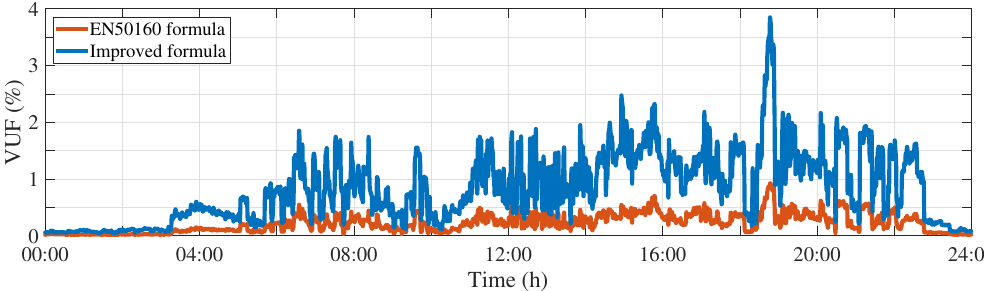
Figure 4. Voltage Unbalance Factor (VUF) formula comparison.